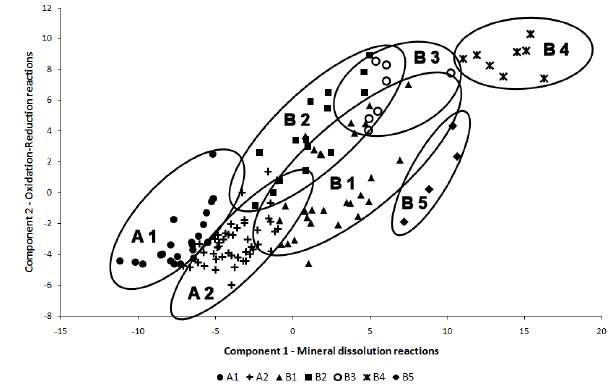
Fig. 9. Plot of principal component scores for Components 1 and 2 for all sites assigned to each of the seven clusters identified by HCA. 4